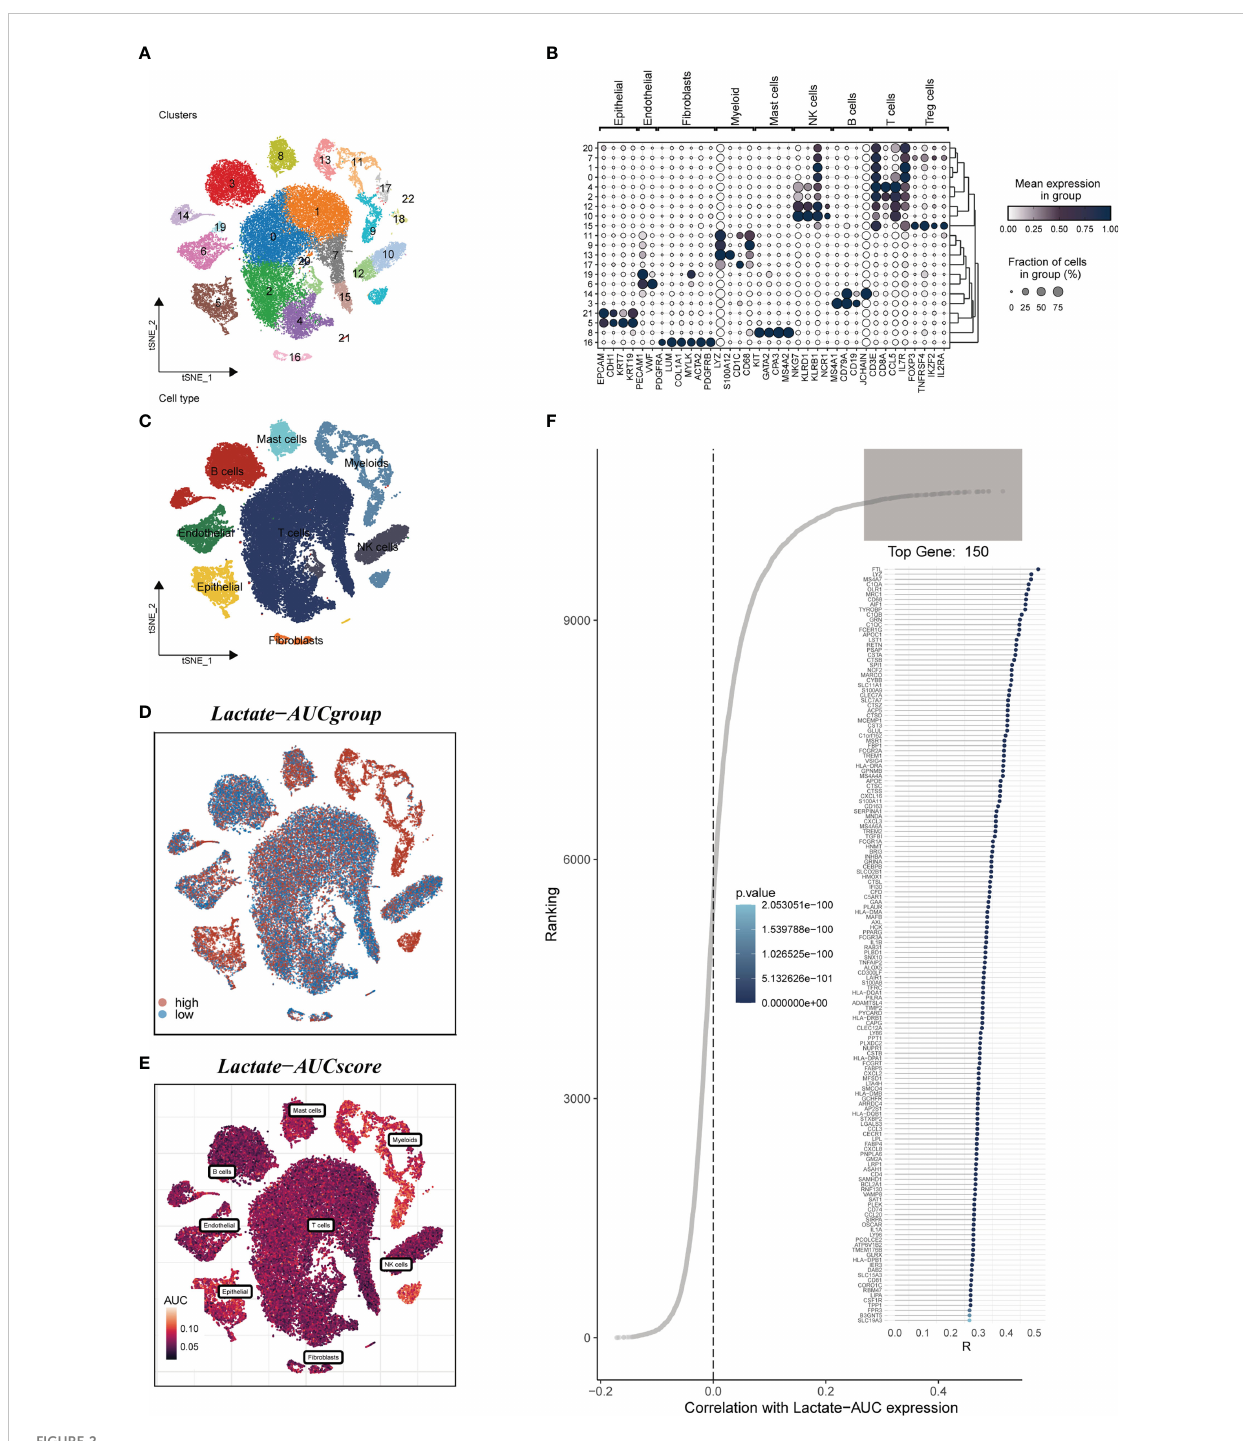
FIGURE 2 Annotation of single-cell data. (A) The t-SNE plot showed that all the cells in 22 clusters. (B) A bubble plot exhibited typical marker genes for each cell cluster. (C) The t-SNE map indicates that LUAD samples can be annotated as 8 cell types in the TME (different colors represent different cell types). (D, E) AUCell score and groups of LM activity in each cell. (F) Correlation analysis between LM-AUCell score and